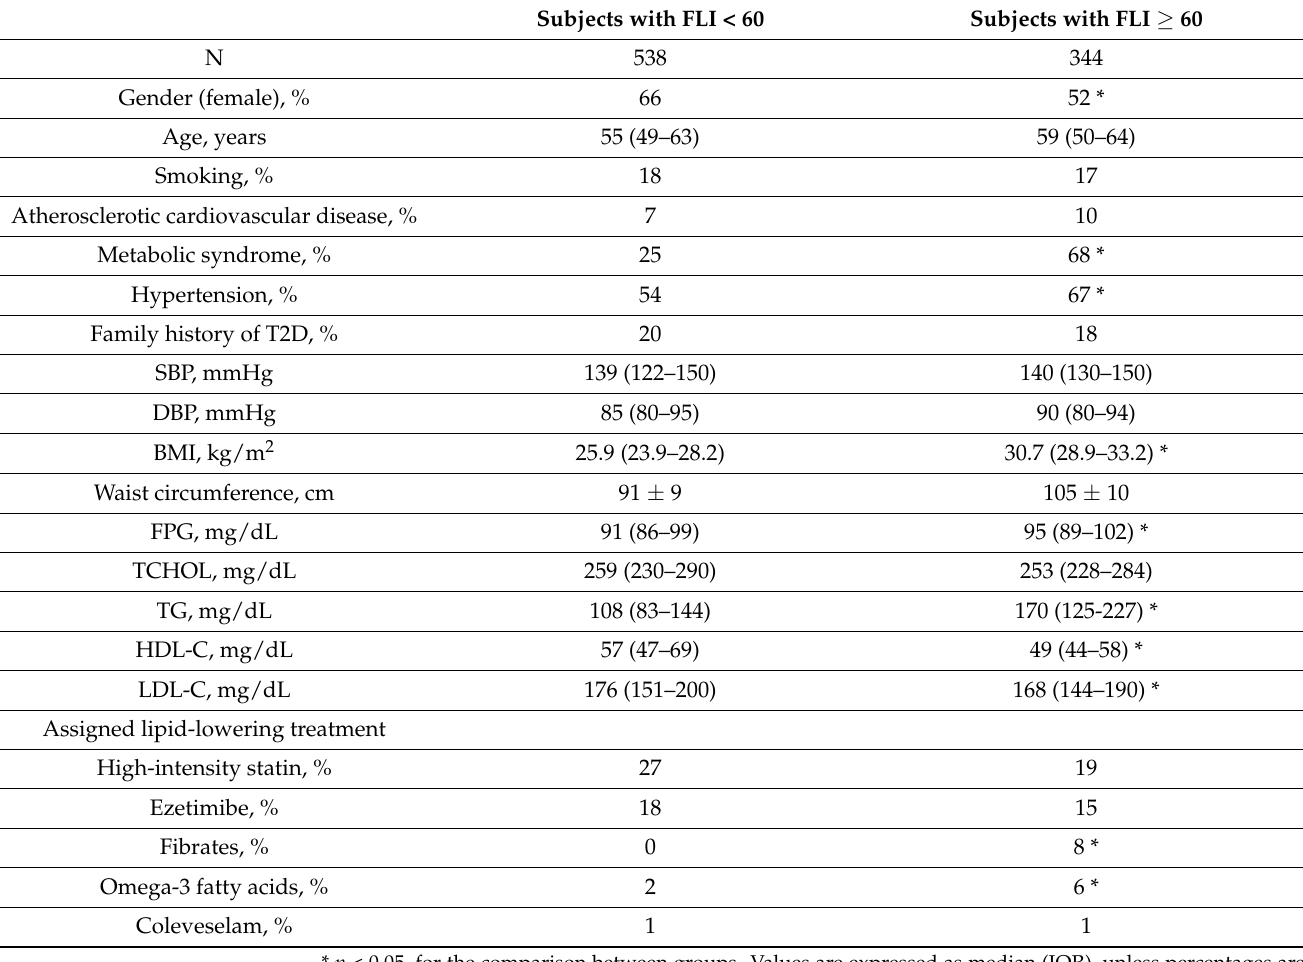
Table 1. Baseline study participants’ characteristics according to FLI cut-off value.